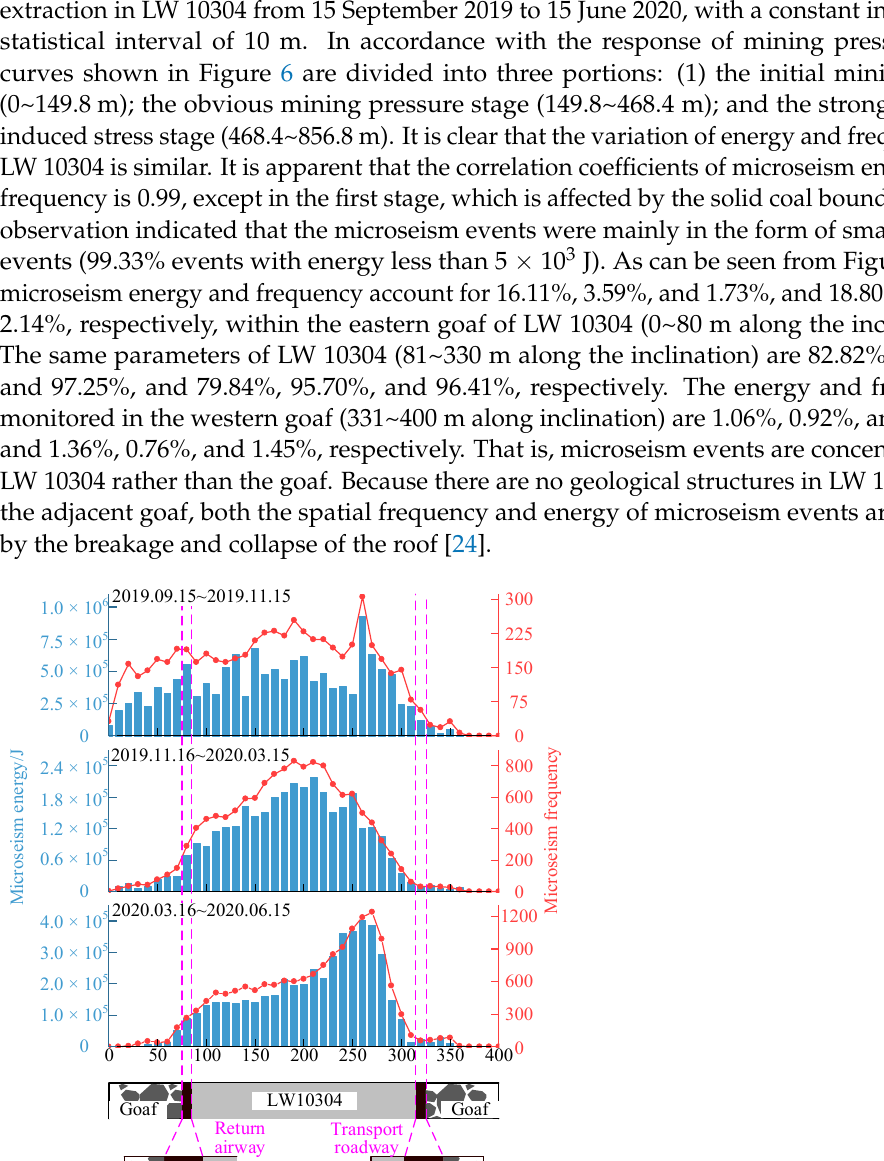
Figure 5. The schematic diagram of overburden structure characteristics of the isolated working face.